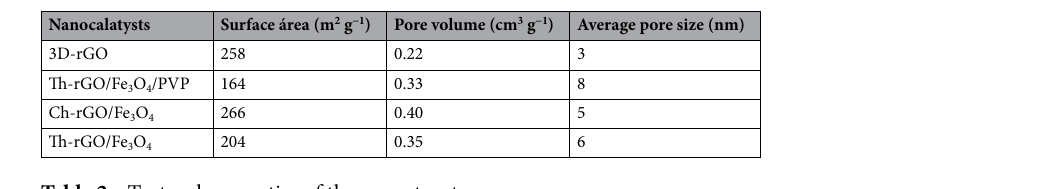
Table 2. Textural properties of the